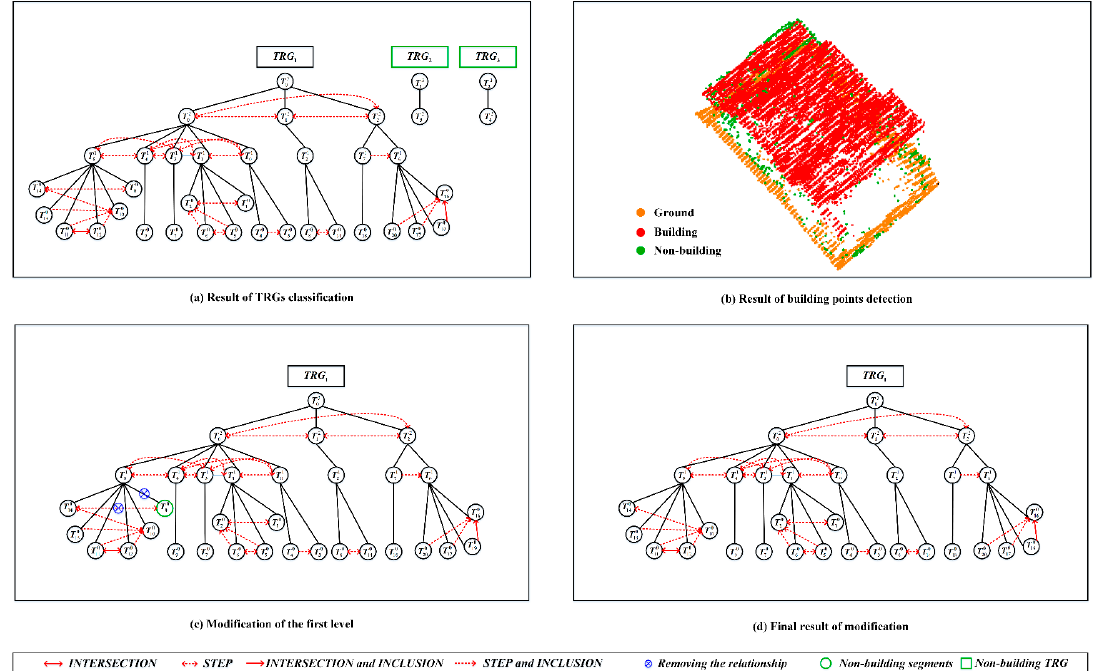
Figure 12. Extracting building points and modifying the TRG from the building candidate region PB in Figure 10c. ( a ) TRG classification. Two TRGs are classified as non-building, and one TRG is labeled as a building; ( b ) Final result of building point detection; ( c , d ) Process of modifying the TRG according to the result of building point detection, and only one segment node is removed.